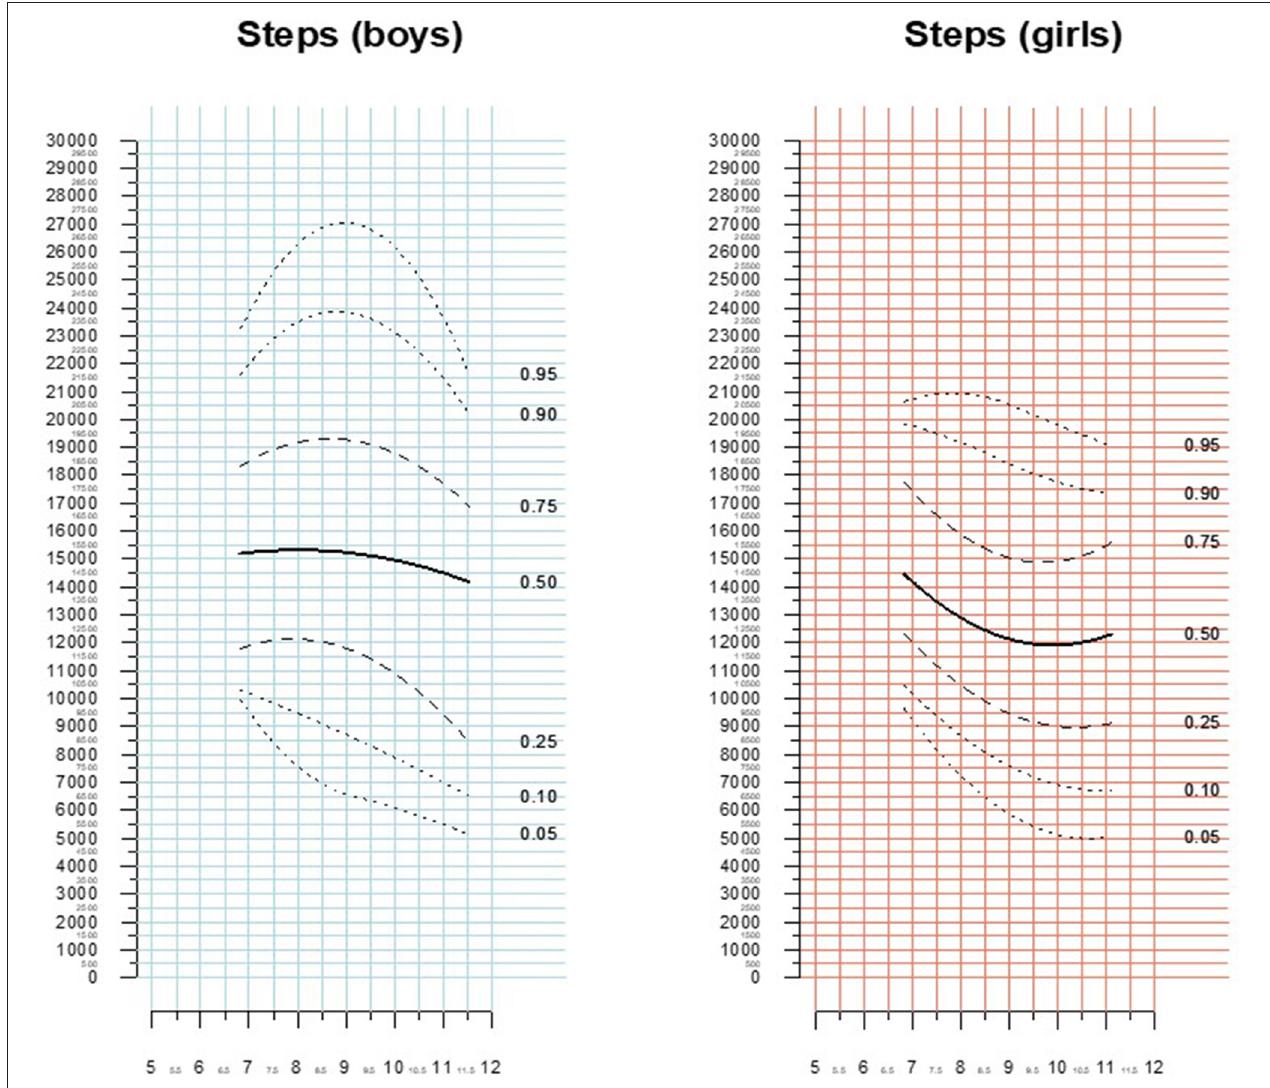
FIGURE 4 | Percentiles of total daily steps (minimum wear time